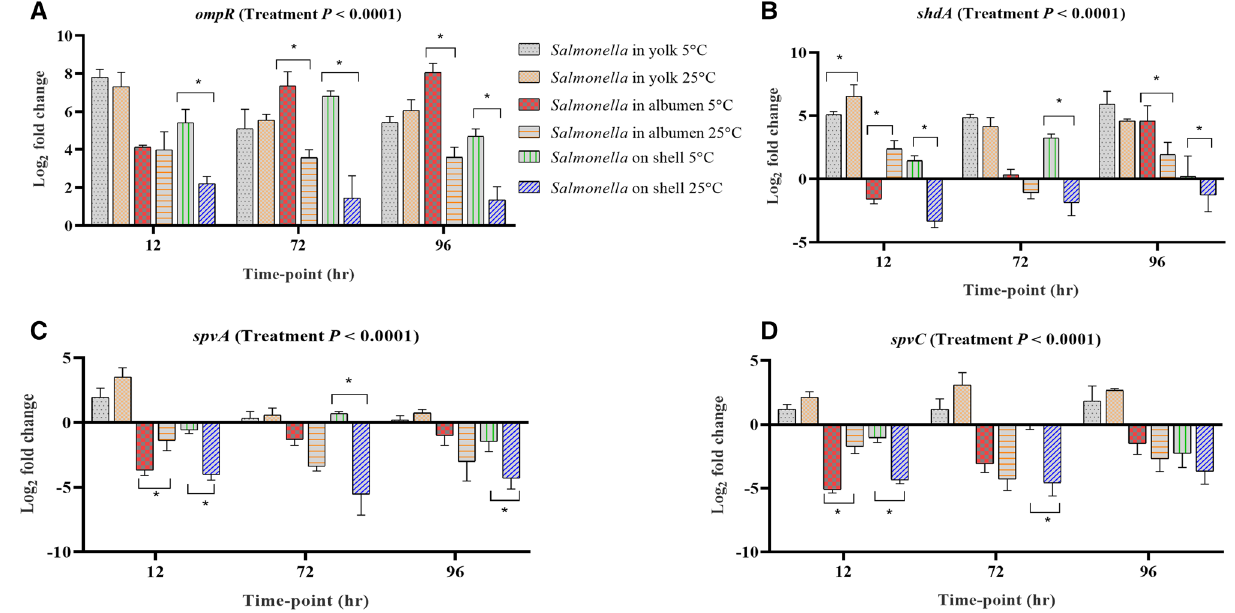
Figure 4. Regulation of genes at different time-points of Salmonella inoculated yolk, albumen and eggshell stored at 5 °C and 25 °C. Relative expression (log 2 fold change ± S.E.) of ( A ) ompR ; ( B ) shdA ; ( C ) spvA and ( D ) spvC . Within each egg component and storage time-point, asterisks across the bars show significant differences (P < 0.05).